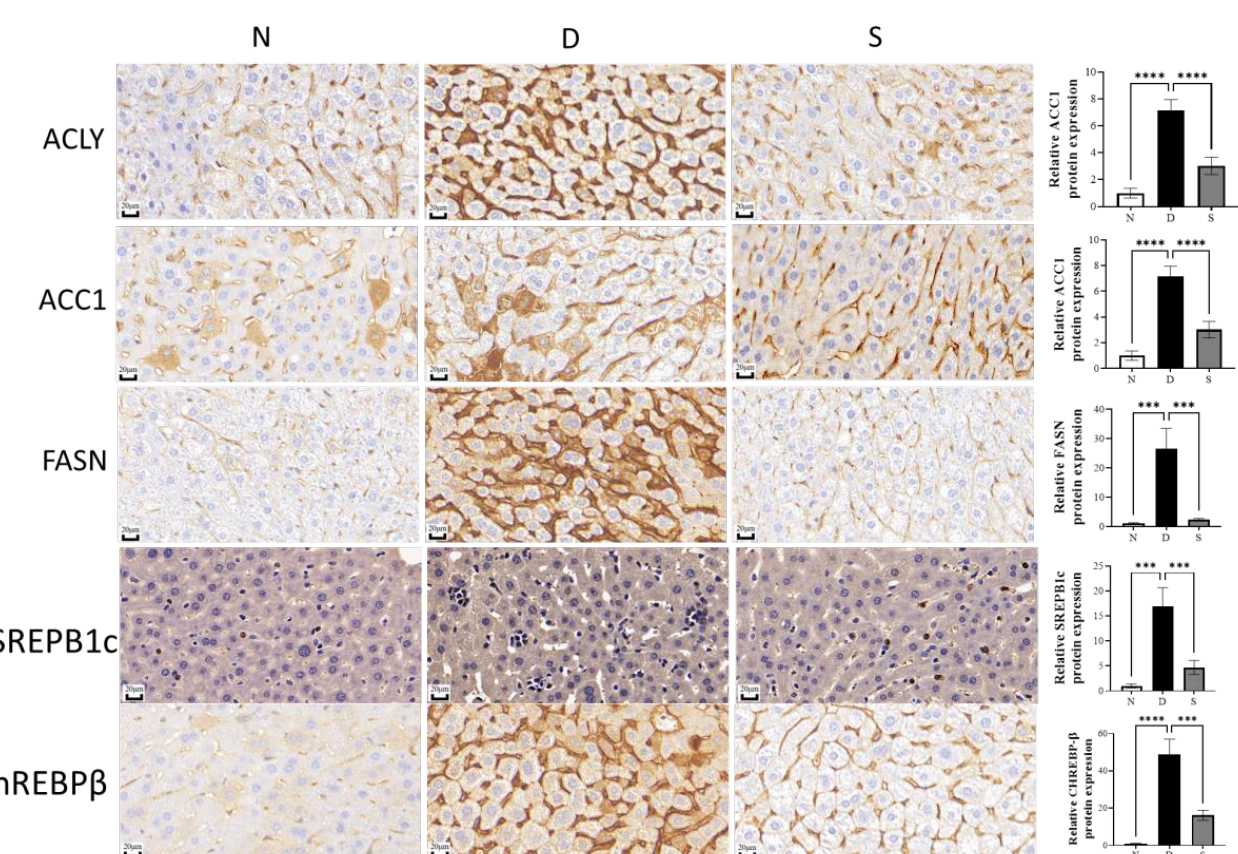
Figure 4. Immunohistochemistry studies of the effect of Swietenine on ACLY, ACC1, FASN, SREPB1c and ChREBPβ and their respective protein expression. N, normal group; D, diabetic mice group; S, treatment with swietenine group (80 mg/kg). In the diabetic group, the levels of the key enzymes involved in de novo lipogenesis (ACYL, ACCA and FASN) levels and the transcriptional regulators (SREPB1c and ChREBPβ) increased significantly. However, the swietenine (80 mg/kg) treatment group significantly reversed the effects. ns: Not significant; *** p < 0.001, **** p < 0.0001.